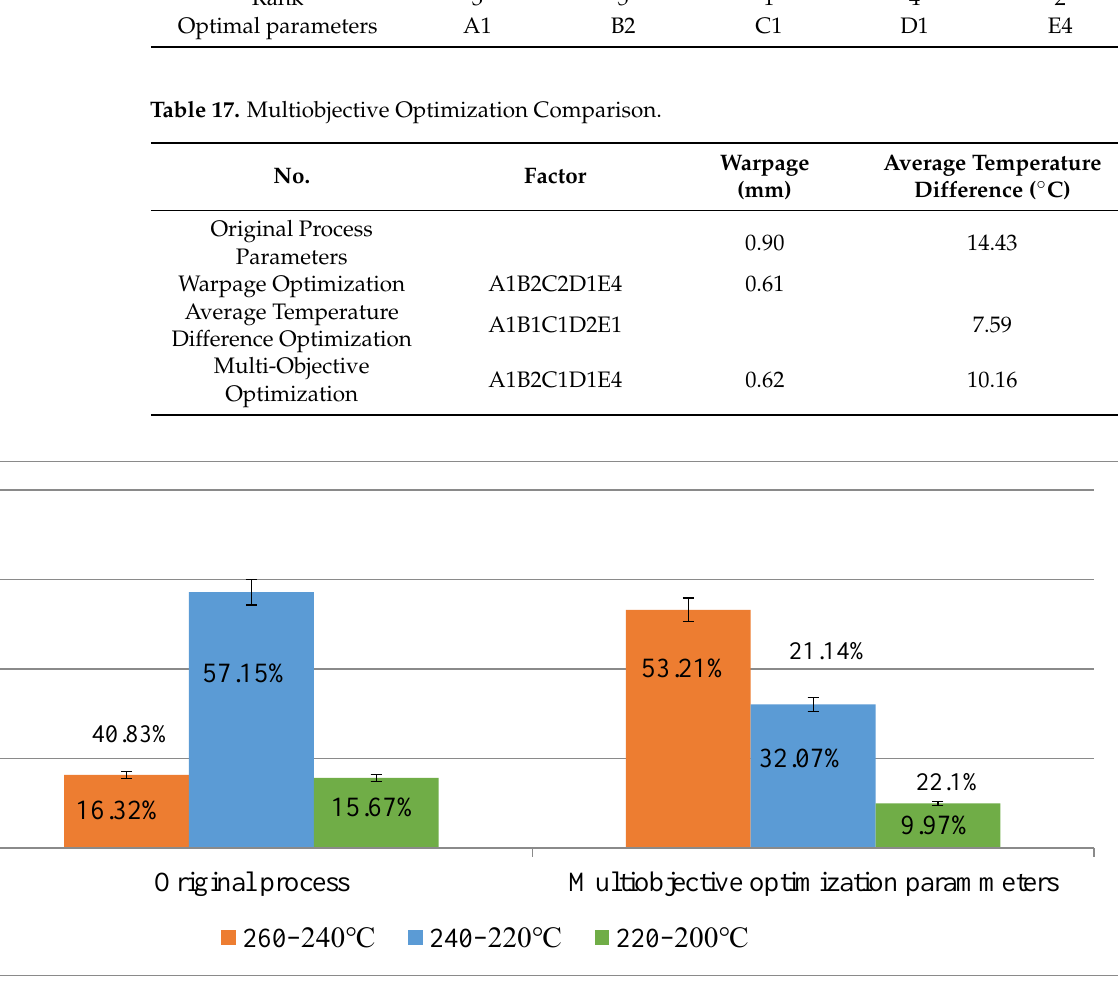
Figure 10. Comparison of Temperature Distribution Intervals.